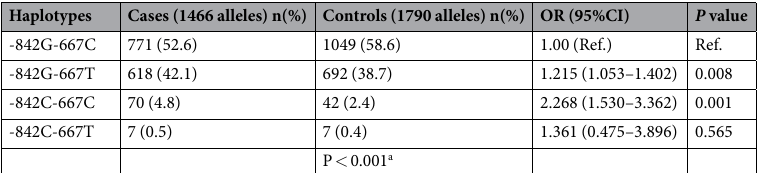
both -842G-667T and -842C-667C haplotype showed an increased risk of nasopharyngeal carcinoma compared to the -842G-667C haplotype. Overexpression of PIN1 was found to enhance cancer growth and aggressiveness in NPC 17 . Functional anal- yses of the PIN1 promoter polymorphism with luciferase reporter assay were performed in our study. The result indicated that the transcription activity driven by the variant -842C-667C and -842G-667T were higher than